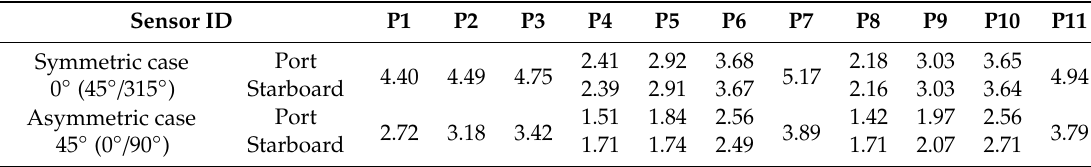
Table 4. Summary of the largest peak values at bow area (in